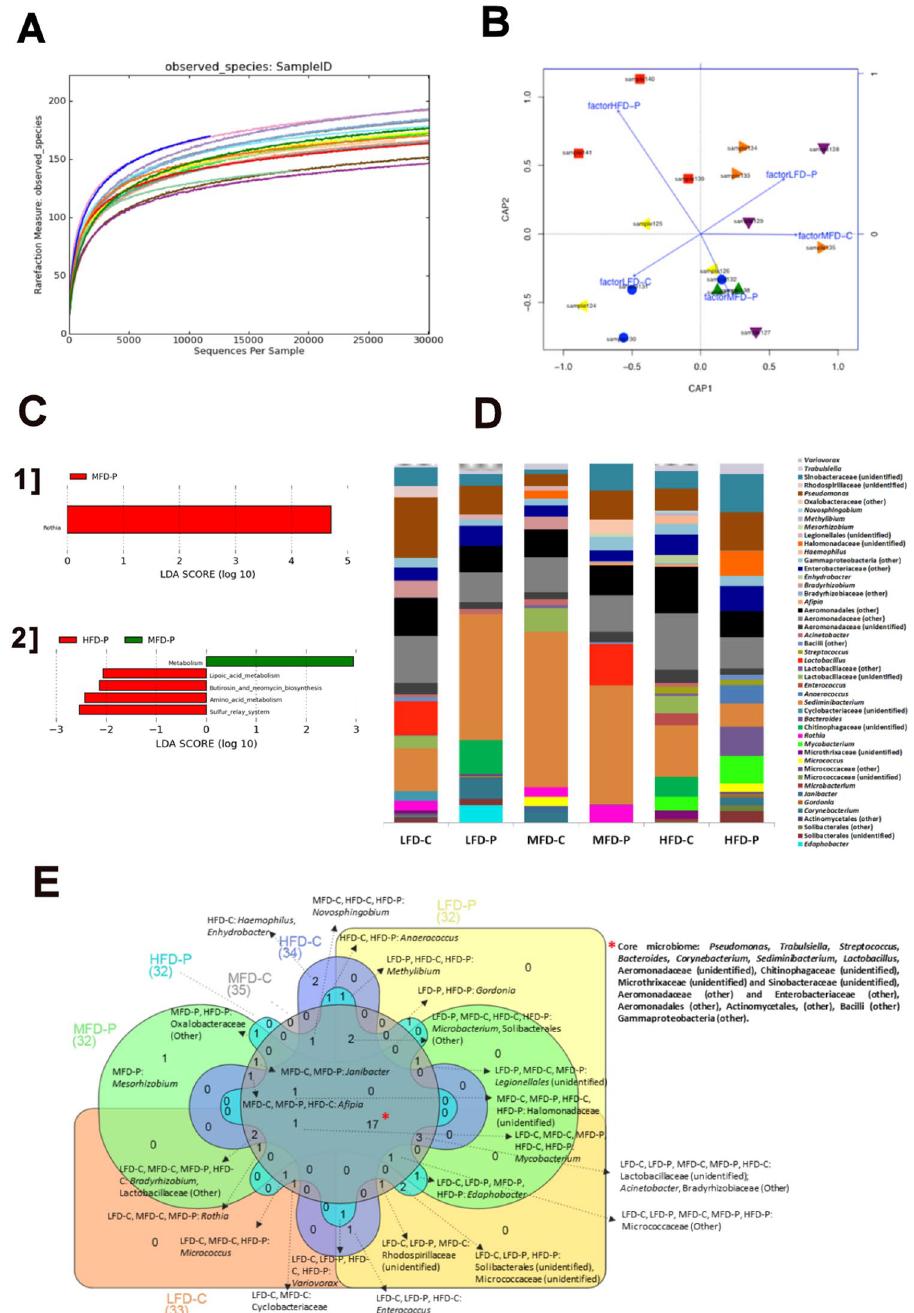
Figure 7. Gastrointestinal bacterial community analysis of zebrafish. ( A ) Alpha rarefaction plot of observed species. ( B ) Distance-based redundancy analysis (db-RDA) using unweighted UniFrac metrics by probiotic supplementation: LFD-P (orange triangules), MFD-C (purple triangules), MFD-P (green triangules), HFD-C (blue circles). ( C ) LEfSe (LDA Effective Size) results of OTUs at genus level (I) and after PiCRUST (phylogenetic investigation of communities by reconstruction of unobserved states) analysis (I) ( p < 0.05) ( D ) Stacked bar chart representing the relative abundance of bacterial genera. ( E ) Core microbiome at genus